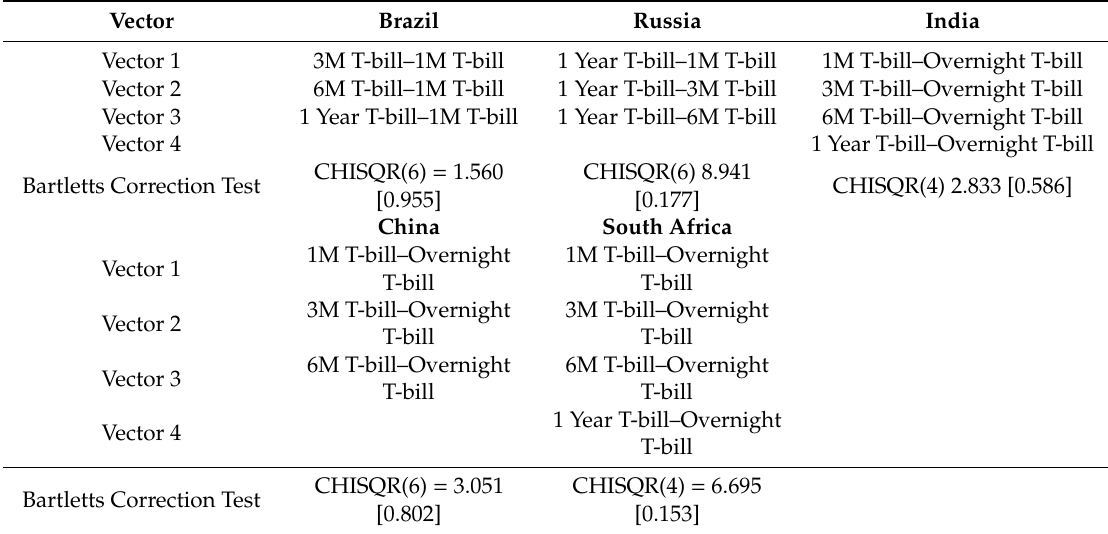
Table 3. Long-run structure